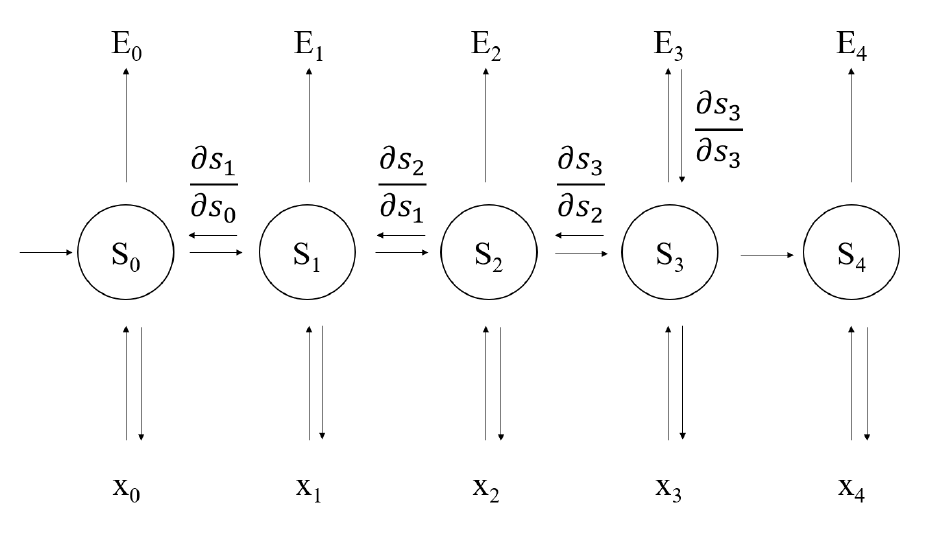
Figure 3. The gradient of error in the